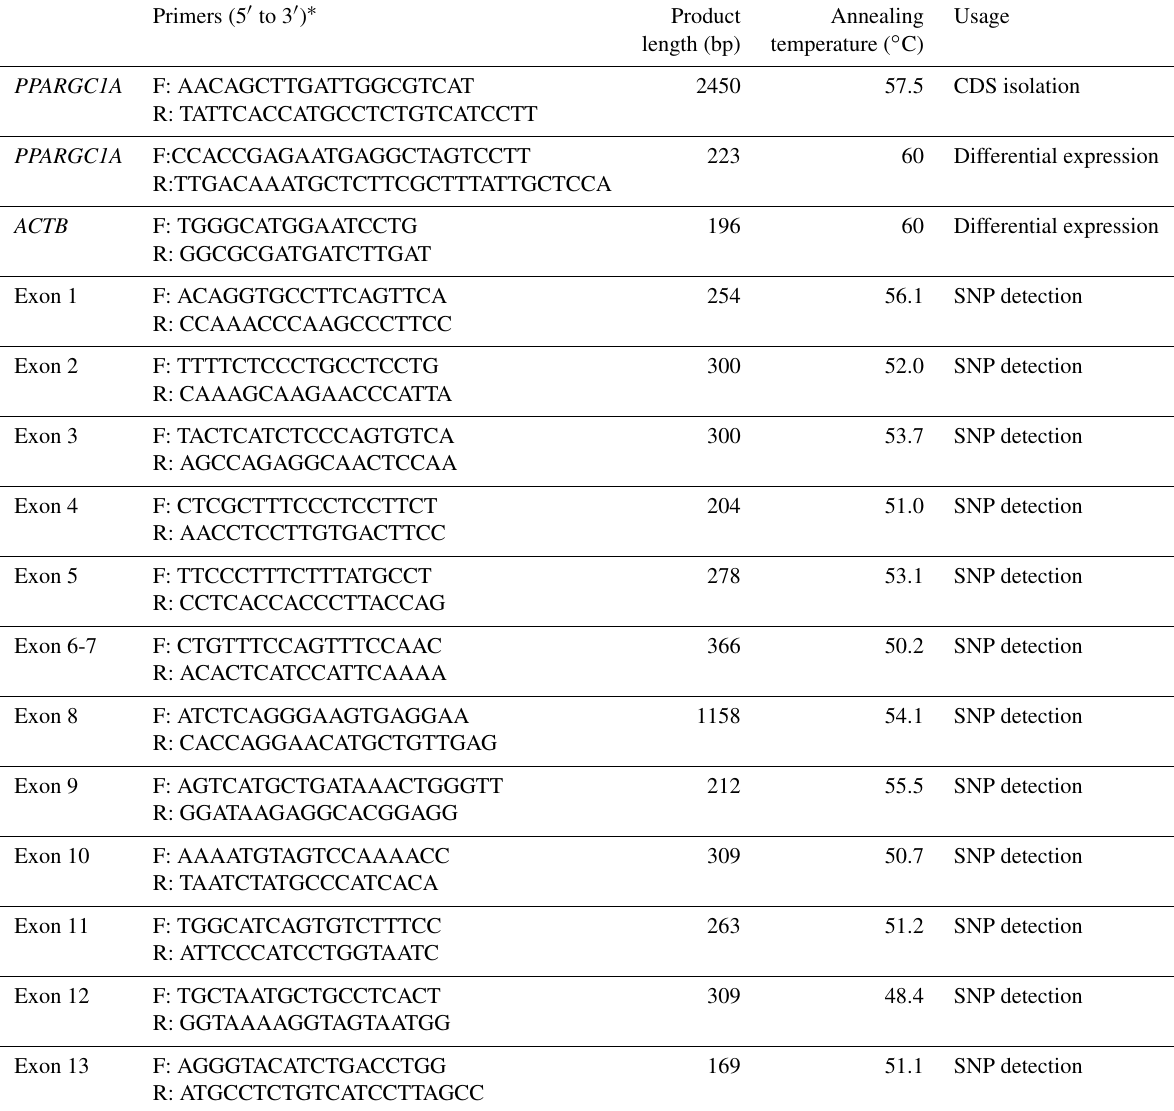
Table 1. Primer information on gene isolation, qPCR and polymorphism identification. Primers (5 (cid:48) to 3 (cid:48) ) ∗